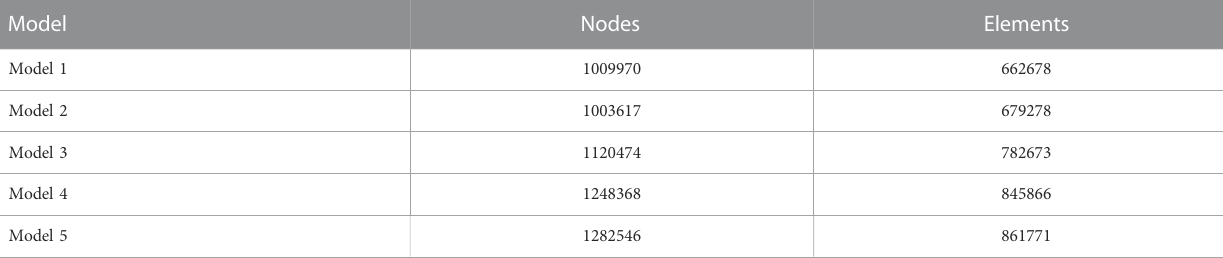
TABLE 2 Number of nodes and elements for the fi ve different